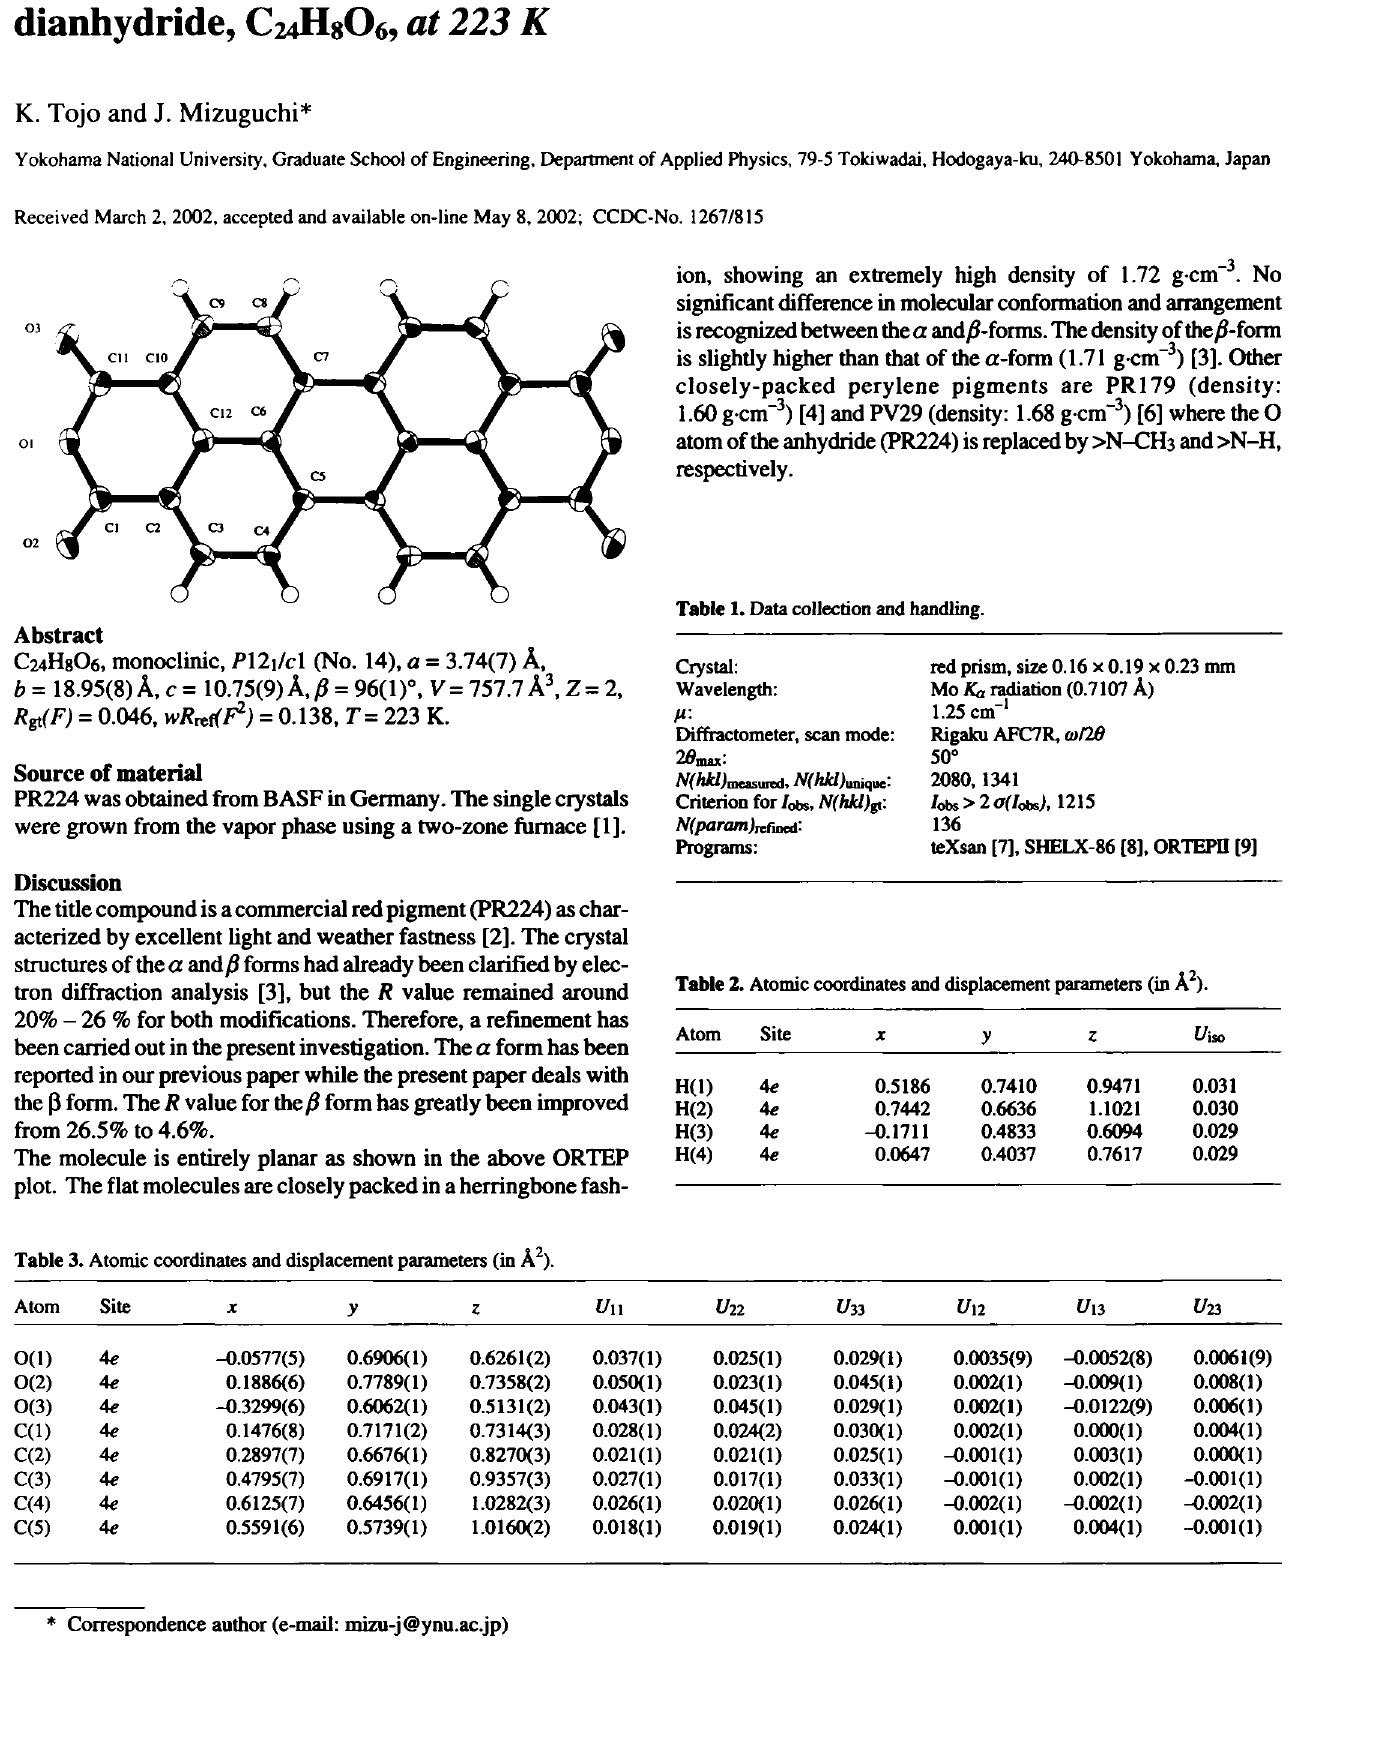
Table 3. Atomic coordinates and displacement parameters (in Â 2